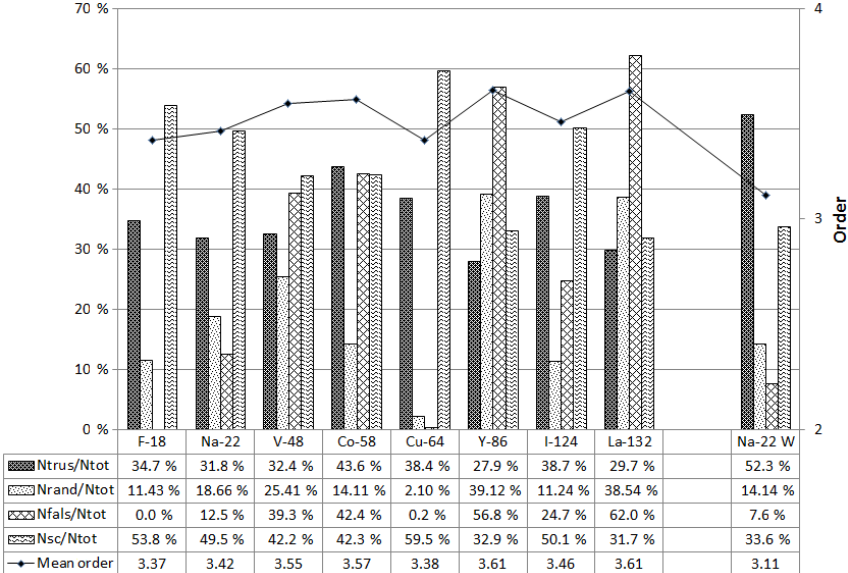
Figure 2. Global result of the MC simulations. Left: line source in Opalinus Clay, filled with 18 F, 22 Na, 48 V, 58 Co, 64 Cu, 86 Y, 124 I, and 132 La. Right: 22 Na – line source in